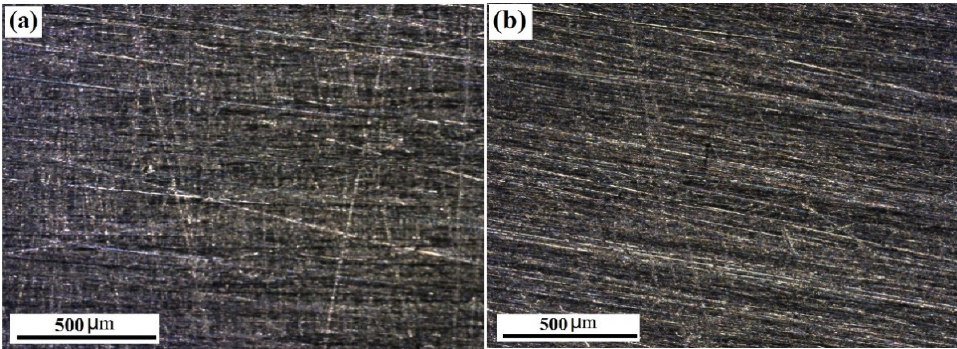
Figure 7. Surface morphology of corrosion coupons of AISI 304 SS: ( a ) before expansion; ( b ) after expansion.